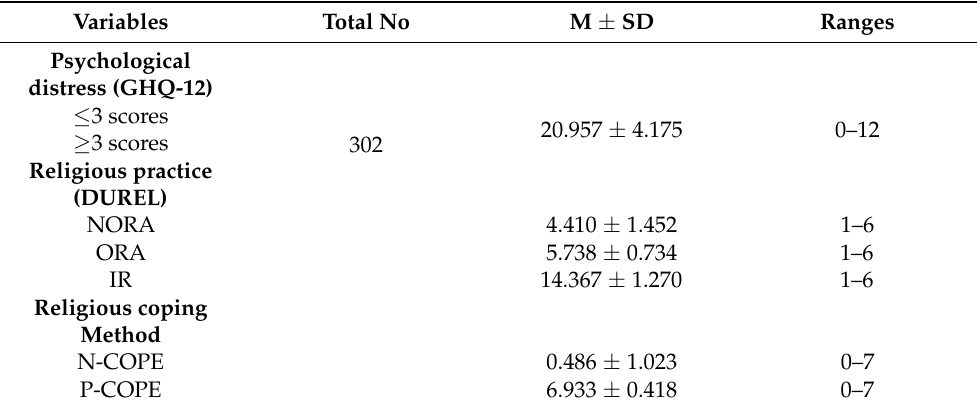
Table 2. Caregivers ’ Mean, Std. Deviation, psychological distress, religious practices, and religious coping.